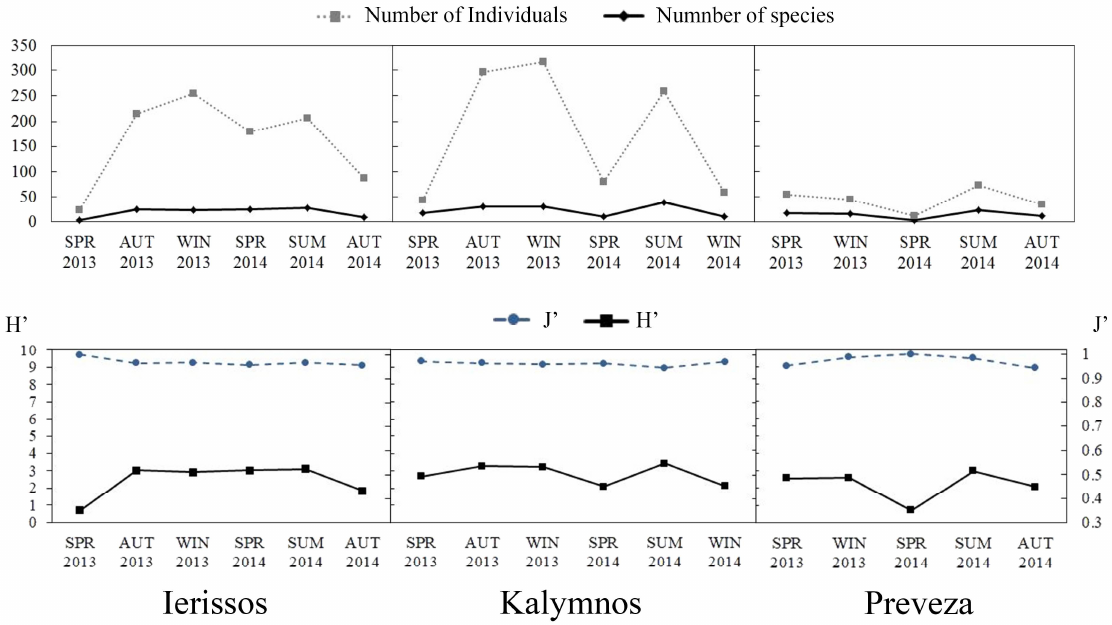
Figure 6. Total abundance of all taxa per area (top); biocoenotic parameters and diversity indices according to location, season, and year (bottom). Pielou’s evenness: J ′ and Shannon–Wiener index: H ′; Spring: SPR; Summer: SUM; Autumn: AUT; Winter: WIN.